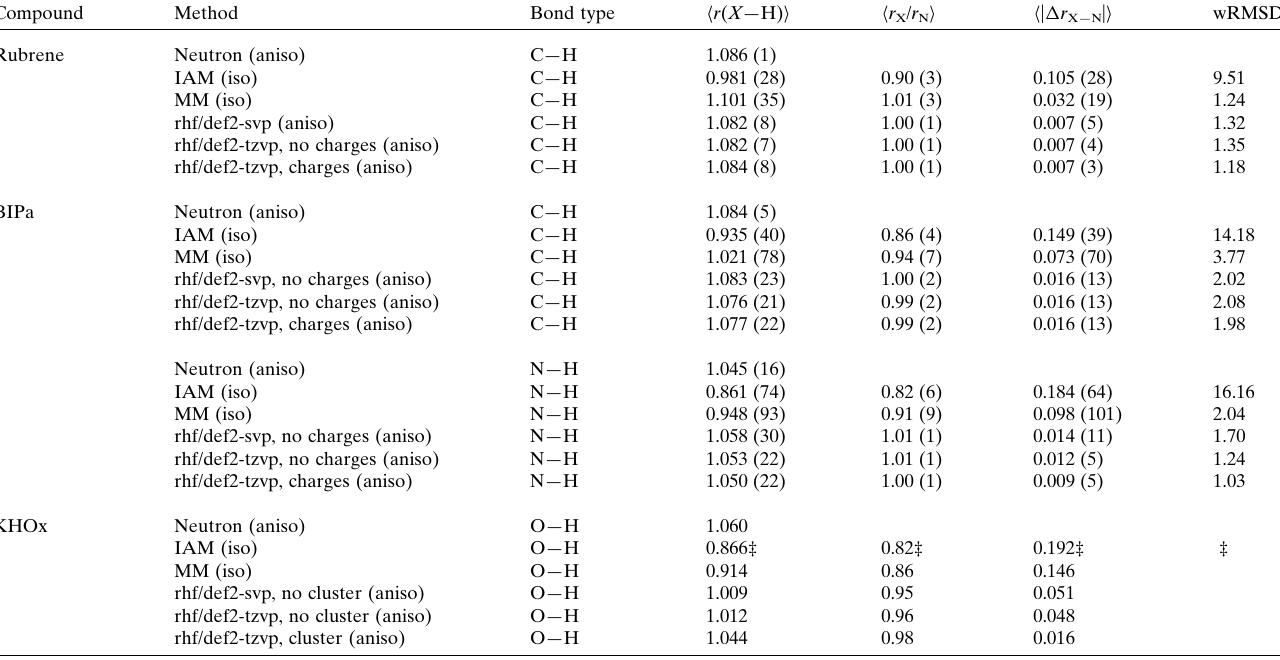
Table 5 Comparison of the element–hydrogen bond lengths r ( X —H) obtained from the X-ray refinement models (IAM, MM and HAR) with the values obtained from neutron